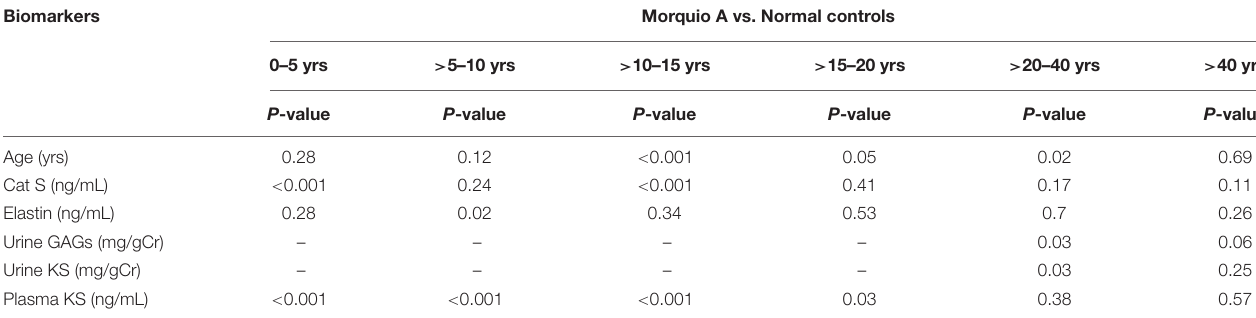
TABLE 3 | Biomarker comparisons between age groups of Morquio A and normal controls. Biomarkers